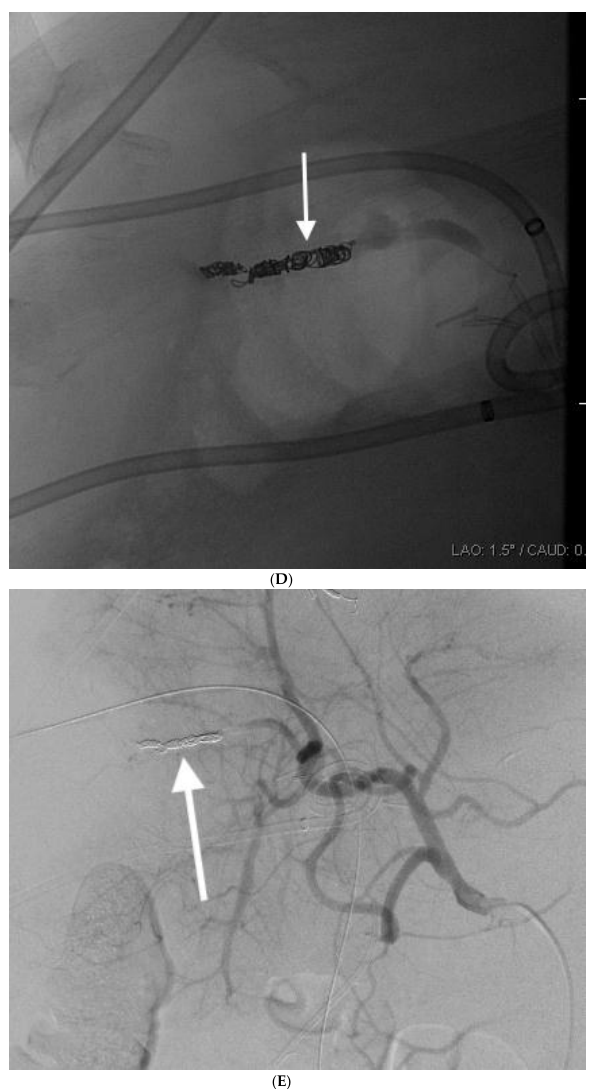
Figure 6. 72-year-old male with a hepatic artery to portal vein fistula. This patient underwent PTBD placement for biliary diversion after a cholecystectomy led to a cystic duct stump leak. He had intermittent episodes of small volume hemobilia. ( A ) Computed tomography angiography (CTA) was performed and showed early opacification of a portal vein branch (curved arrow) for which he was referred for hepatic arteriogram. Celiac ( B ) and selective right hepatic ( C ) artery angiograms demonstrated hepatic artery (straight black arrows) to portal vein (curved black arrows) fistula, relatively remote from the PTBD. This injury was therefore thought to be related to initial needle passes. ( D ) The hepatic artery supplying this fistula was coil-embolized (white arrows). ( E ) Repeat hepatic angiogram demonstrated cessation of the arteriovenous